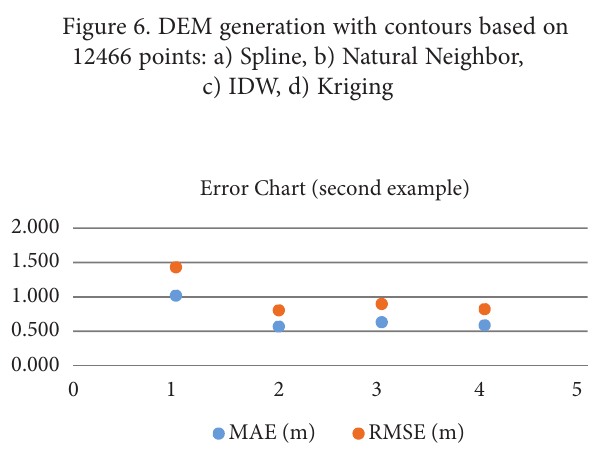
Figure 7. Error chart of the four interpolation methods for 12466 sample points